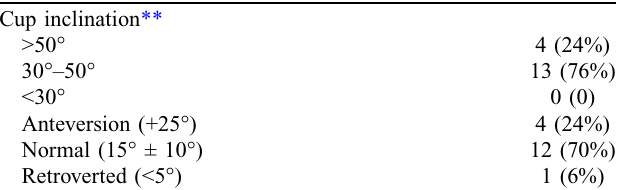
Table 1. Baseline characteristics. Table 2. Cup